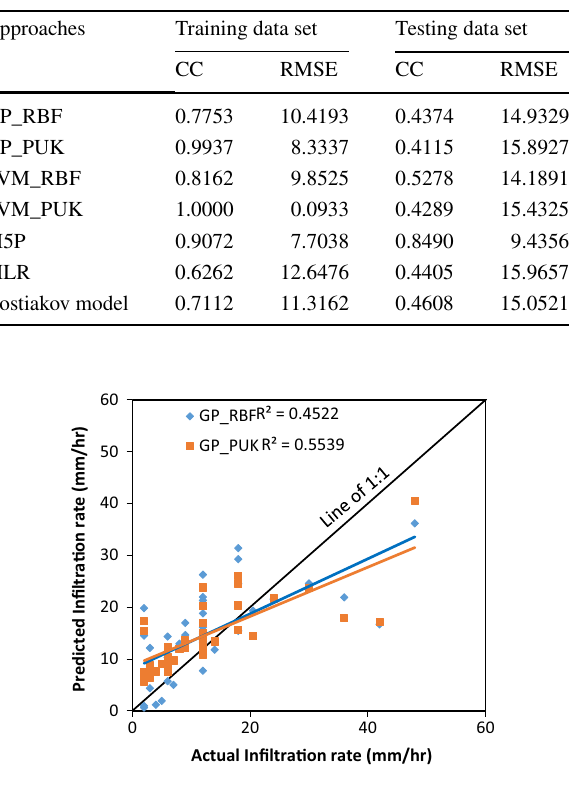
Fig. 3 Predicted infiltration rate of soil using GP_RBF and GP_PUK